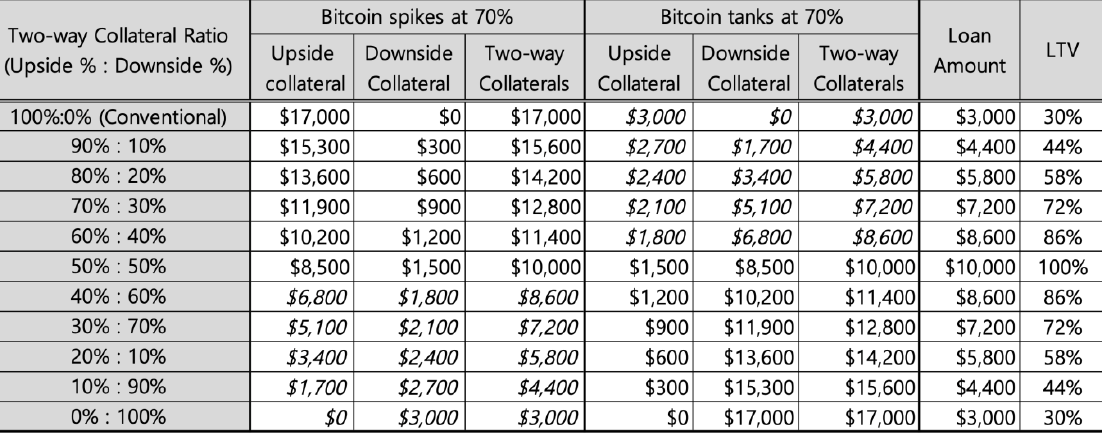
Note: Collateral = 1 BTC; the prices of Bitcoin, upside collateral, and downside collateral at the time of loan commitment = $10,000; Upside and downside collateral area (1x) long position and (-1x) short position, respectively. The two-way collateral ratio of 100:0 corresponds to a conventional secured